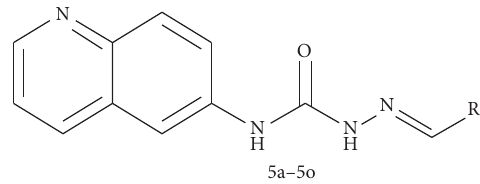
Figure 2: Structures of target compounds